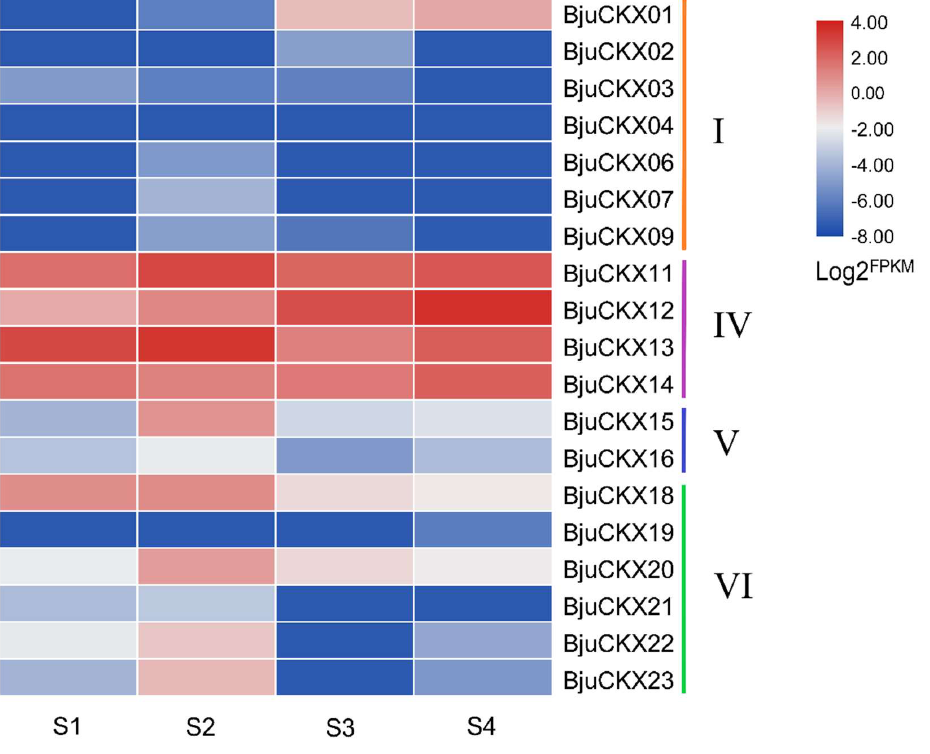
Figure 7. Transcriptional expression analysis of CKX gene family in B. juncea var. tumida . The color scale bar on the right side of heatmap corresponds to the value converted by log2FPKM; the more red, the more the transcripts were abundant.